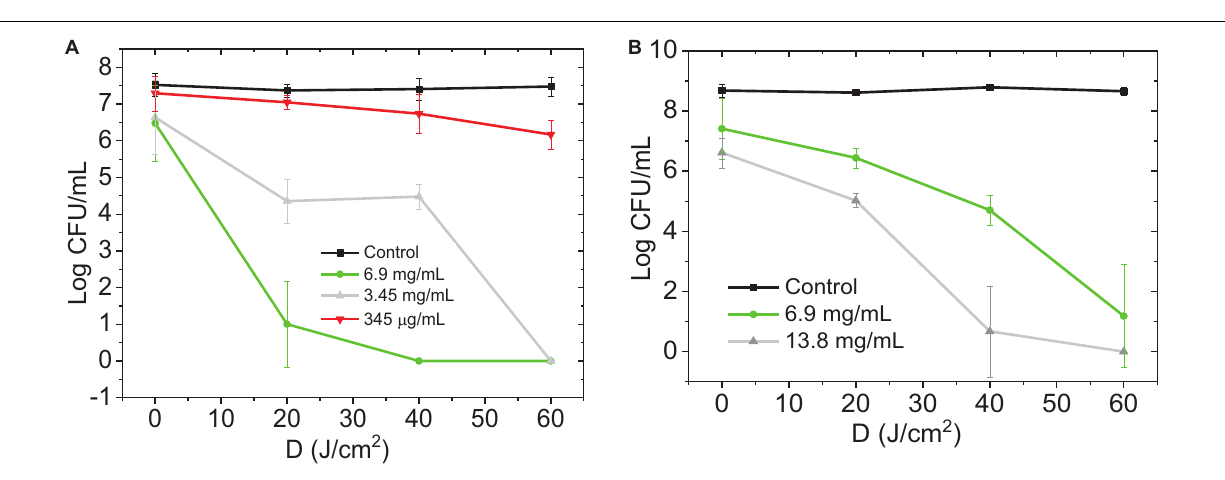
FIGURE 6 | Photoexcited C-DOTS reduce the number of bacterial colonies (log CFU/mL) based on the light dose 450 nm, 40 mW/cm 2 delivered. (A) Planktonic S. aureus + C-DOTS. (B) Biofilm of S. aureus + C-DOTS. The “control” group refers to the bacteria + light system. The group “0 J/cm 2 ” corresponds to the bacteria + C-DOTS system, where it was observed that the C-DOTS by themselves decreased the bacterial population in 10 2